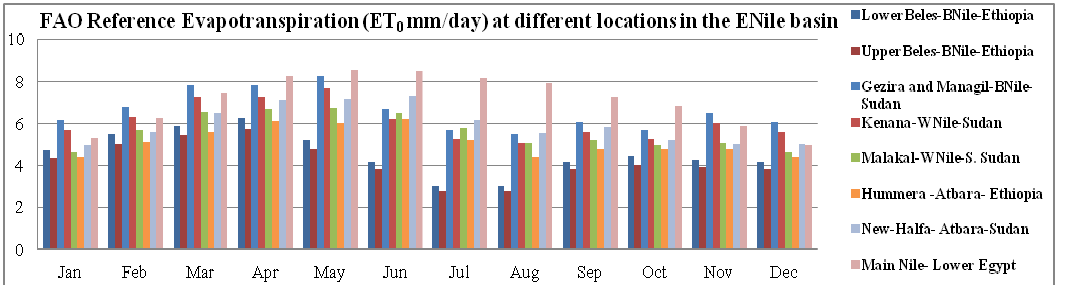
Figure A1. The monthly reference evapo-transpiration (ET 0 ) at different locations in the Eastern Nile Basin. Source: Digna et al., 2018. Table A1. Major reservoirs, hydropower plants and irrigation projects in the Eastern Nile. Sources: Verhoeven, (2011); Goor, (2010); ENTRO, (2007); Van der Krogt and Ogink, (2013).